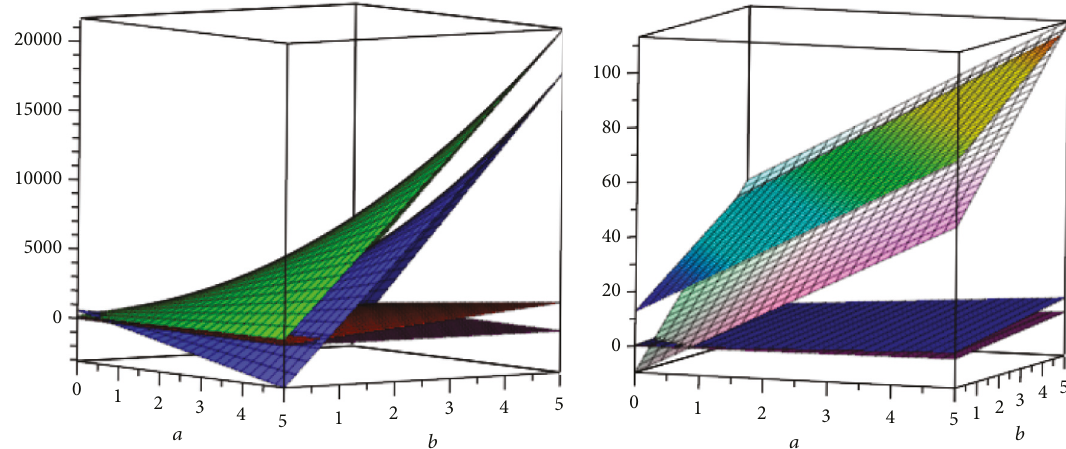
Figure 11: Variations of the NGHI and NHGI for Si